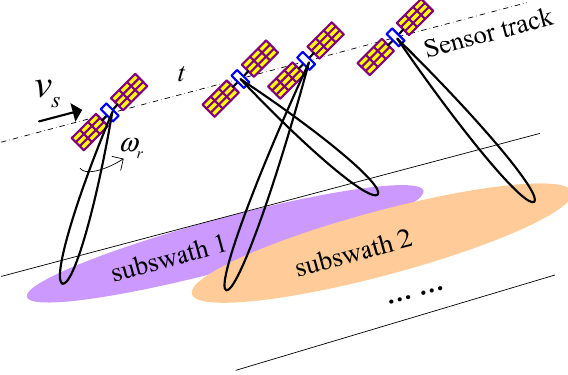
Figure 1. Terrain Observation by Progressive Scans (TOPS) mode acquisition